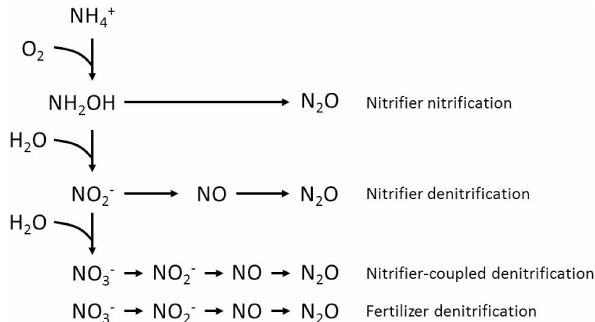
Figure 2. Different pathways of N 2 O production in soil. Classi- cal nitrification by autotrophic bacteria or archaea (nitrifier nitrifica- tion); nitrifier denitrification by the same group of autotrophic bac- teria; nitrification followed by denitrification (nitrification-coupled denitrification) and direct denitrification of applied nitrogen fertil- izer (fertilizer denitrification). Reproduced from Kool et al.